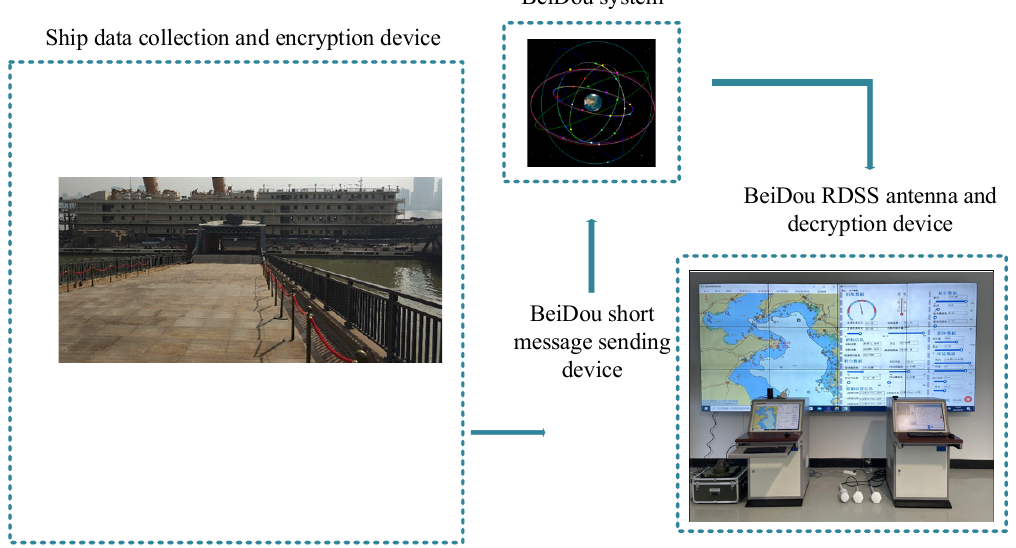
Figure 8. Experimental equipment used to verify the encryption scheme described in this study.